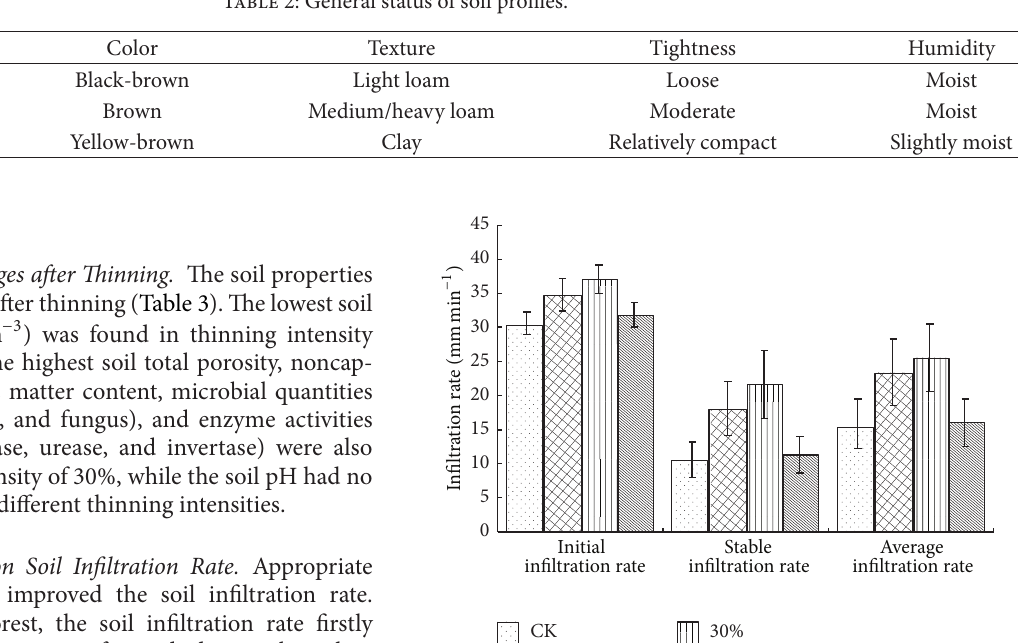
Table 2: General status of soil profiles.